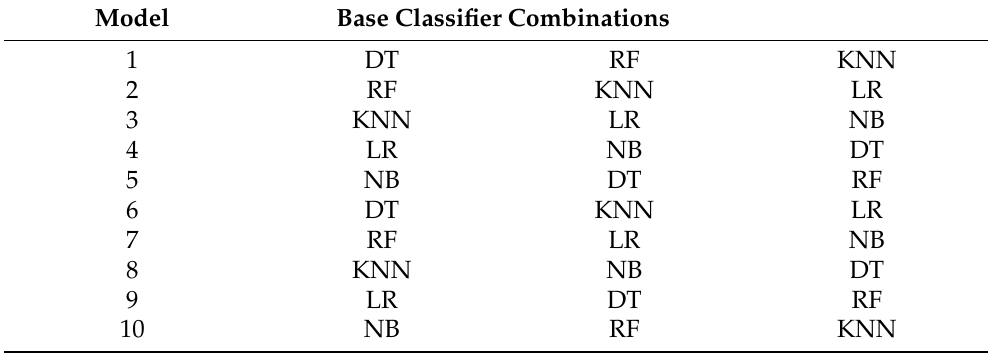
Table 2. Base classifier combinations: decision tree (DT), random forest (RF), K-nearest neighbor (KNN), logistic regression (LR), naïve Bayes